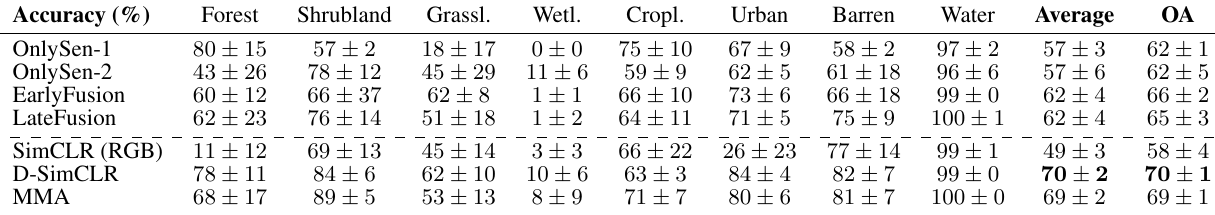
class distribution ( e.g. , 1600 instances of Forest , but only 99 of Barren ), we oversample rare classes during training by draw- ing multiple 128 × 128 pixel crops at random locations from the original images. This results in a dataset of 10,393 observations with approximately uniform class distribution. This dataset is randomly divided into training and validation splits which con- tain 80% and 20% of the data, respectively (resulting in 4102 unique training samples). We tune hyperparameters (batch size, based on the performance on the validation split. Model per-